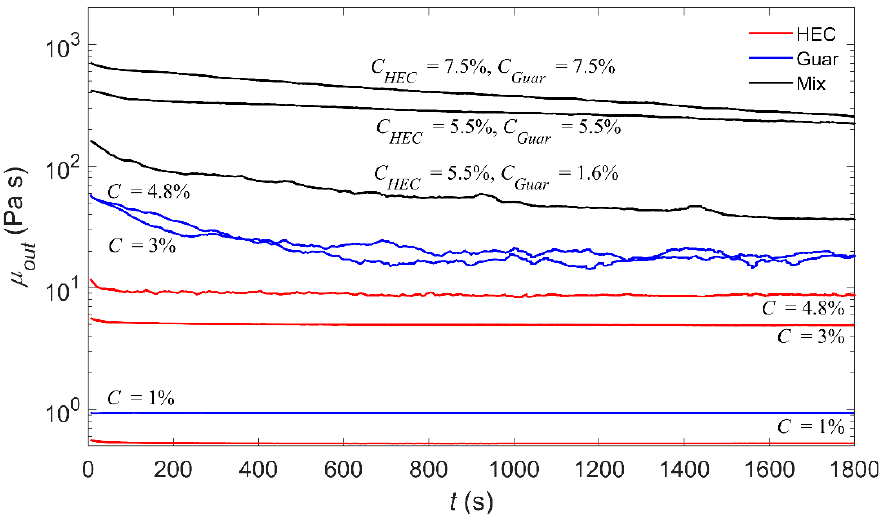
Figure 1. Variation in time of substrate viscosity during rheometer tests. Next to each curve, the concentration of thickener(s) in % w/v is reported. Substrates whose viscosity exceeded about 10 Pa s were strongly thixotropic.